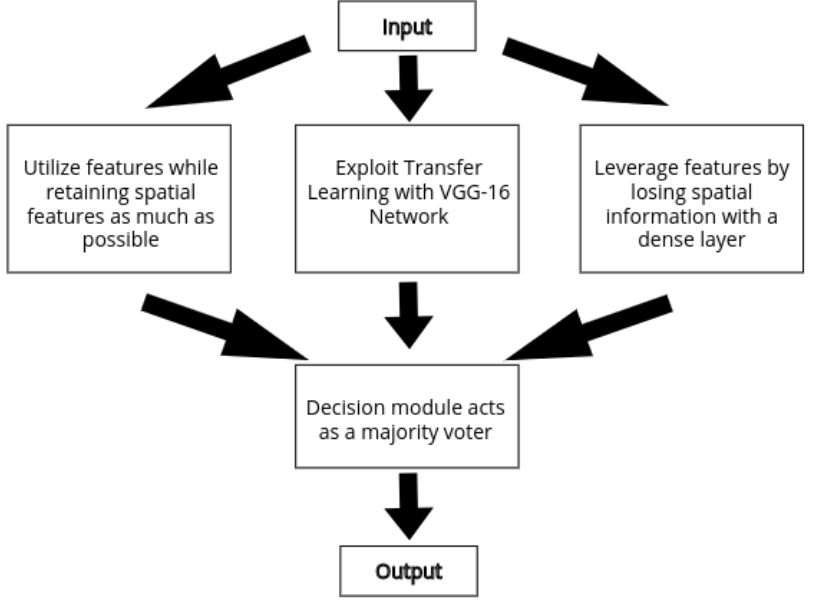
Figure 10. The final ensembled model for homoglyph